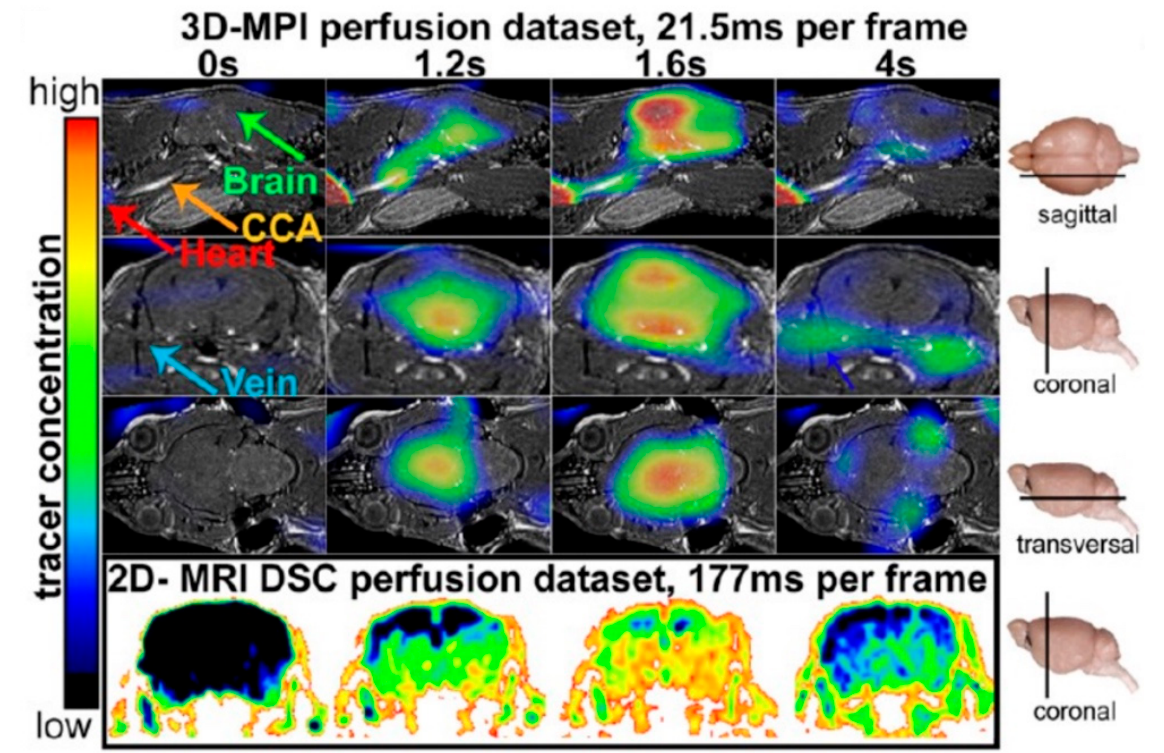
Figure 2. Tracers of SPIO bolus passing through the stroked brain of a mouse. Slices of fused 3D MPI data at several times are shown for the coronal, sagittal, and transverse planes. (Red arrows: occluded and non-occluded common/internal carotid. Blue arrow: the basilar artery). MR dynamic susceptibility contrast (DSC) images are shown for comparison (bottom row). Reprinted with permission from Ludewig et al. [72].